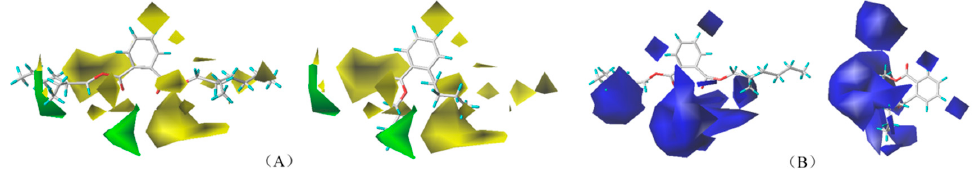
Figure 2. Three-dimensional isopotential maps corresponding to the stereo ( A ) and electrostatic ( B ) fields of the CoMFA model describing the DEHP and DBP molecules.